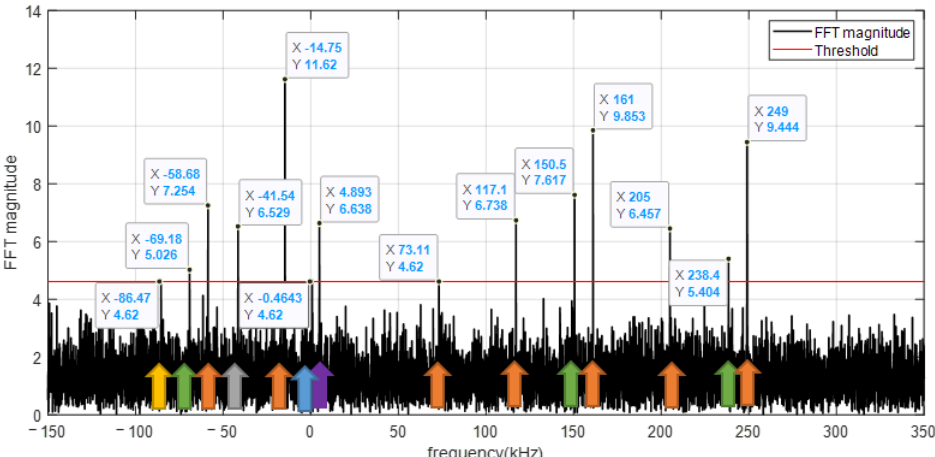
Figure 2. FFT magnitude centered at 11,325 MHz. The arrows of the same color indicate the tones transmitted by the same satellite. Four satellites are captured in total, with a number of tones varying from 1 to 6. Tones indicated by arrows with the same color belong to the same satellite.